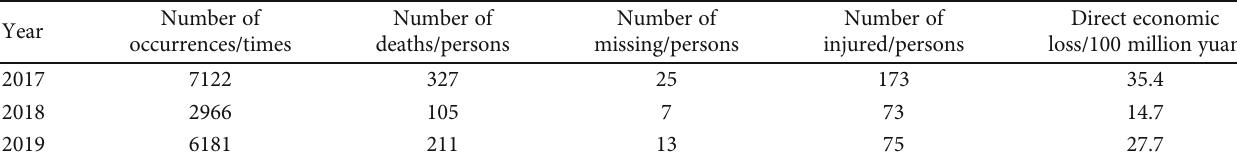
Table 1: Statistics of geological disasters in China from 2017 to